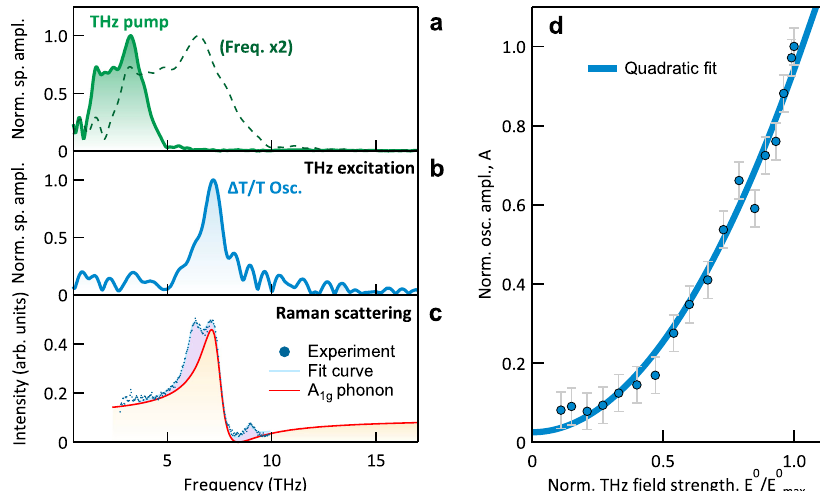
Fig. 2 THz fi eld-driven lattice phonon oscillations in frequency domain. a Normalized spectral amplitude (Norm. sp. ampl.) of the THz pump pulse in Fig. 1d (green solid curve) and same spectrum with 2x frequency (green dashed curve). b Fourier transform of the oscillatory component of Δ T / T for t pp > 0.4 ps (blue curve). c Raman spectroscopy of V 2 O 3 thin fi lm at 300 K. Light blue dots are experimental data and light solid curve is the fi t curve, which contains different spectral components: two E g modes and the A 1 g . The red curve is lineshape of the A 1 g phonon, which is peaked at 7.1 THz. Vertical offset of -0.5 has been added to the experimental data for the overlap with the A 1 g phonon lineshape. Data without offset is shown in Supplementary Fig. 4 and discussed in Supplementary Note 3. d Normalized oscillations amplitude (Norm. osc. ampl.) vs the normalized (Norm.) THz fi eld strength, E 0 / E peak , with E peak = 6.5 MV/cm. The amplitude scales quadratically with the pump electric fi eld (the light blue solid line represents a quadratic fi t). Error bars indicate the standard deviations of the mean determined from pump-probe scan measurements with 15 acquisitions per